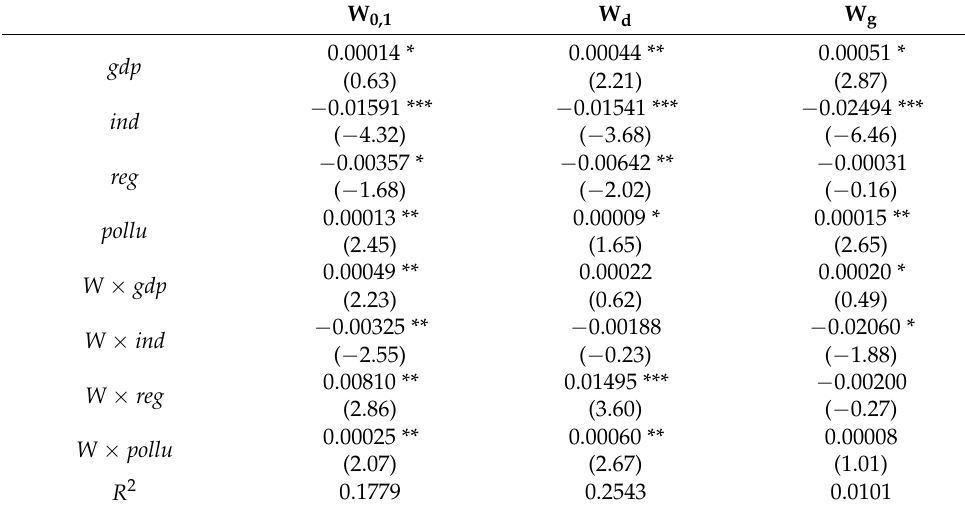
Table 5. Regression results on factors influencing marine fisheries vulnerability.